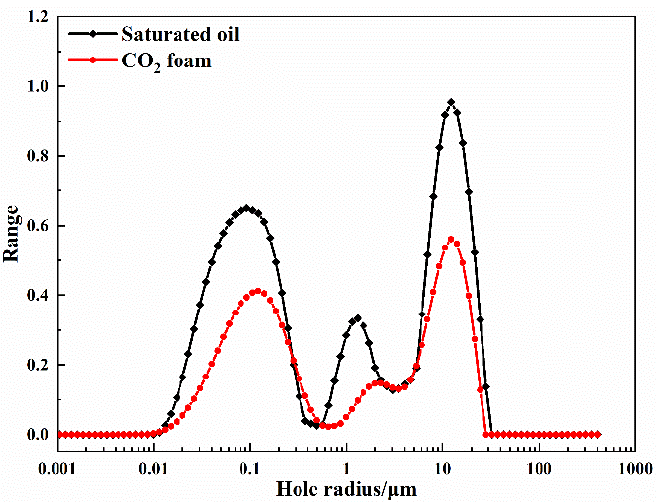
Figure 5. Pore throat radius distribution before and after CO 2 foam injection in core No.1.